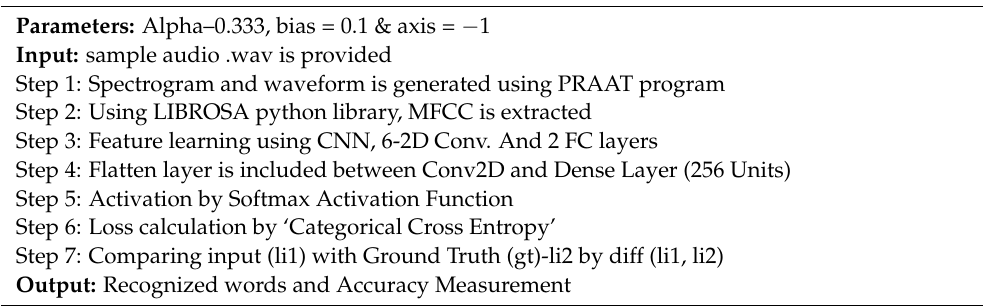
Algorithm 1. CNN implementation for the speech recognition system.